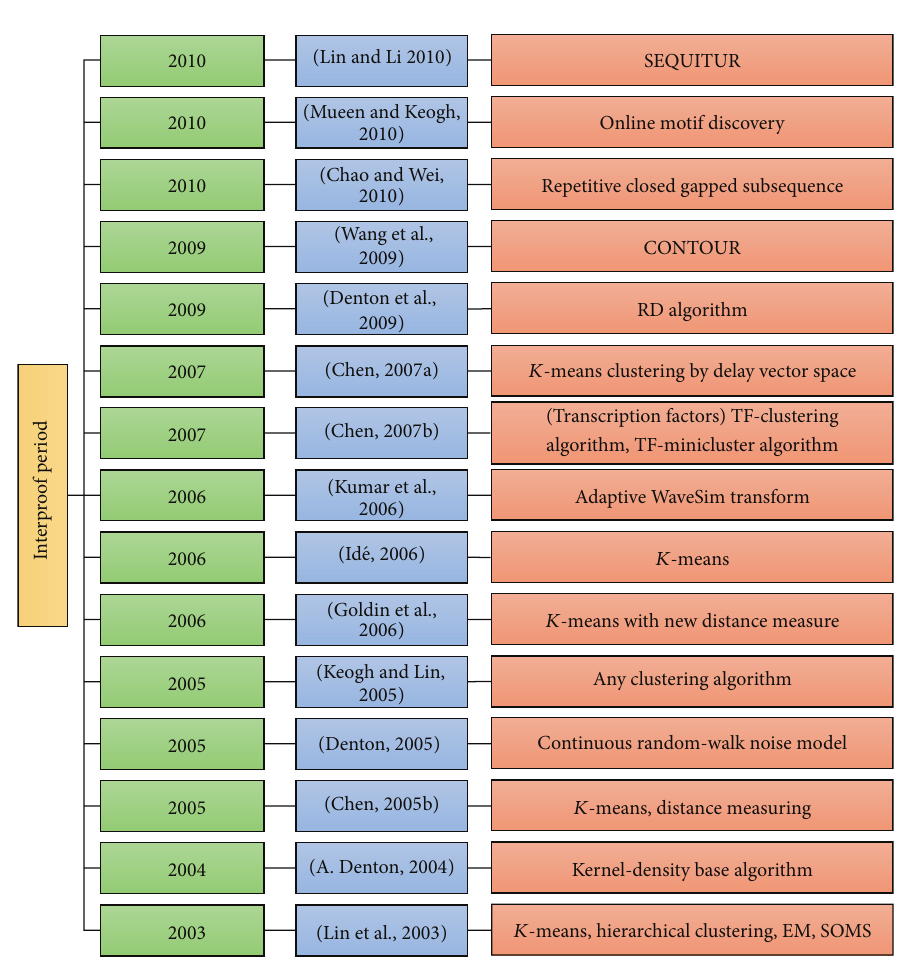
Figure 6: The chronology of methods in interproof